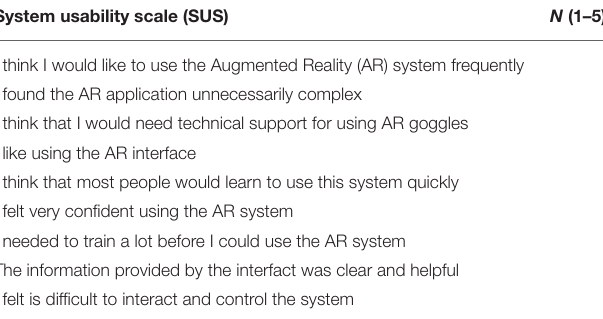
TABLE 1 | System usability scale